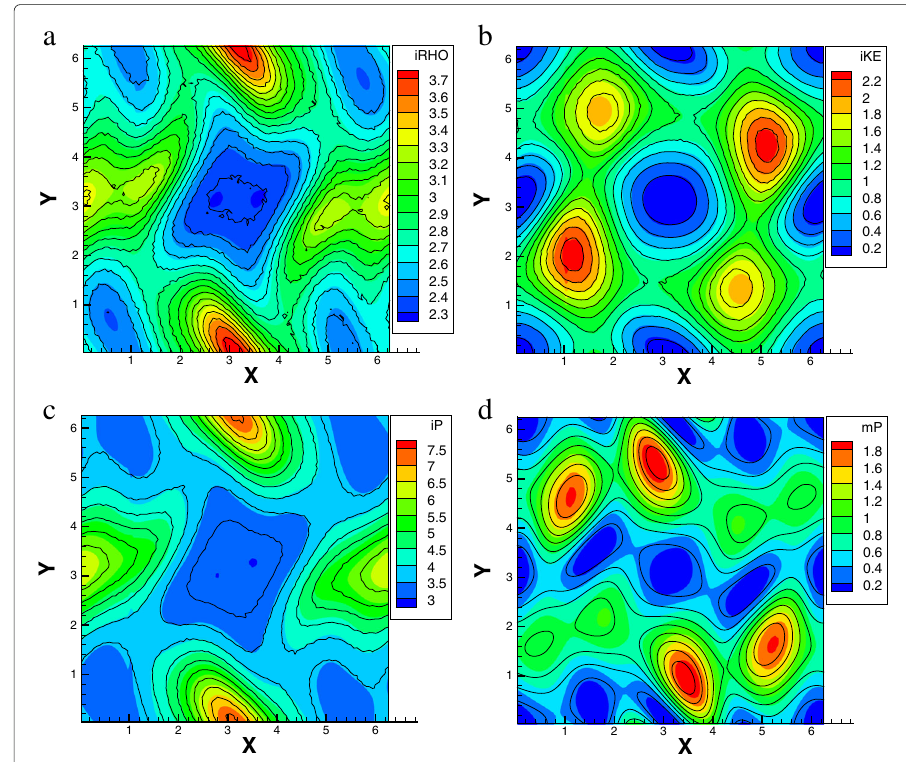
Fig. 12 The results of the multiscale Orszag-Tang vortex problem with Kn 1 and r 10 3 at t 1. Contour lines show the UGKWP solutions and contour floods show the UGKS